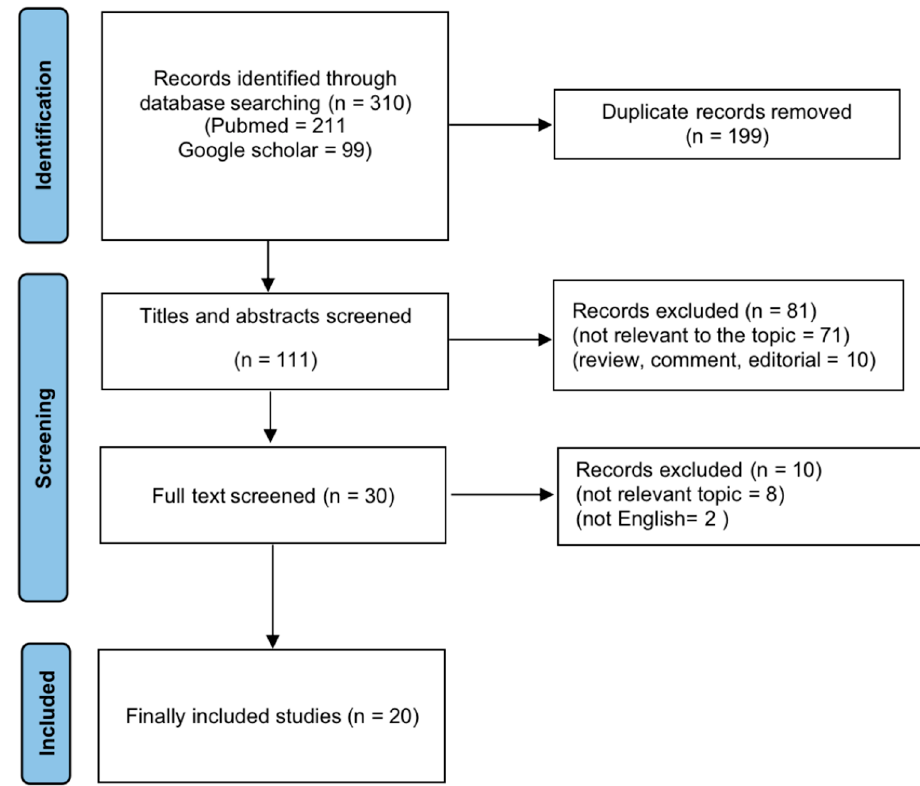
Figure 1. Flowchart of study selection for this study.